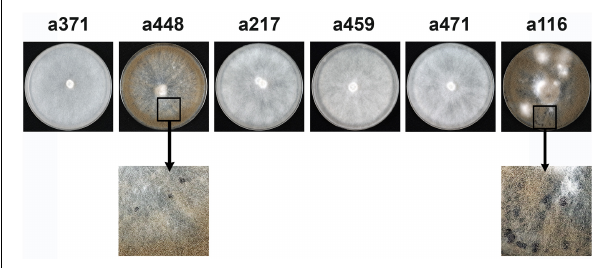
FIGURE 6 | Complementation analysis between mutations in the Bcin04g03490 alleles. Primary transformants of isolate B371 generated with plasmids harboring the alleles indicated were transferred to selection plates and incubated for 14 days at 22 ◦ C in dark conditions. Sporulation and production of sclerotia were evaluated as indicators of functional